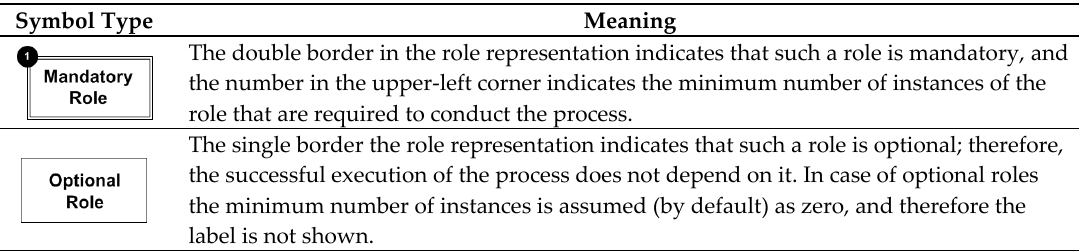
Table 5. Nodes enriched representation.